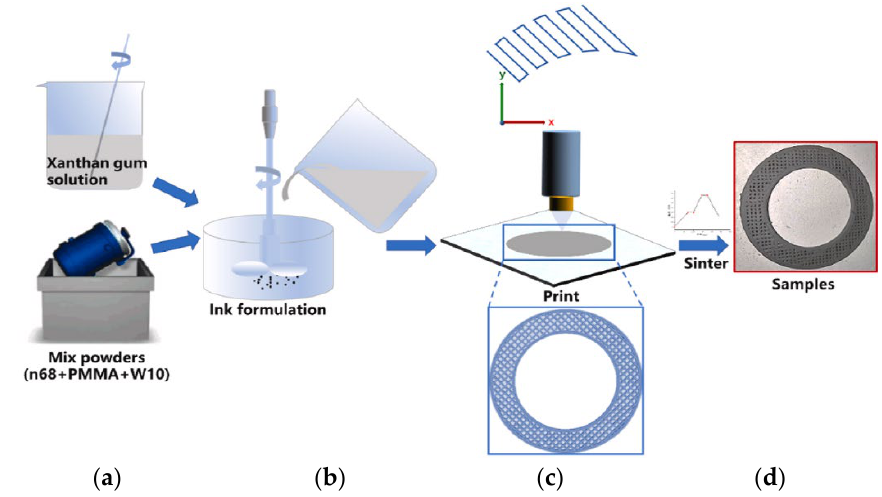
Figure 17. Fabrication procedure of the diamond grinding wheel by DIW: ( a ) mixing of components, ( b ) formulation, ( c ) printing and ( d ) final appearance of the sample [99].